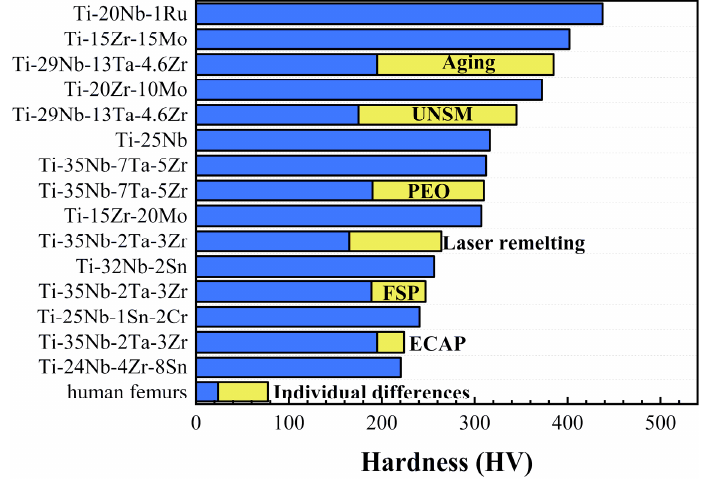
Figure 3. The hardness of different composition and modified β -Ti alloys. Reprinted with permission from ref. [45,55–60]. Copyright Elsevier, 2003, 2013, 2015, 2019, and 2021. FSP, as a novel solid-state surface modification technique, is an attractive method for inducing localized thermomechanical effects [61]. In order to modify the surface of the newly developed Ti-35Nb-2Ta-3Zr (wt.%) alloy, Wang et al. [56] explored the microhardness value of deformation pass from single pass to three passes at the same rotation speed.